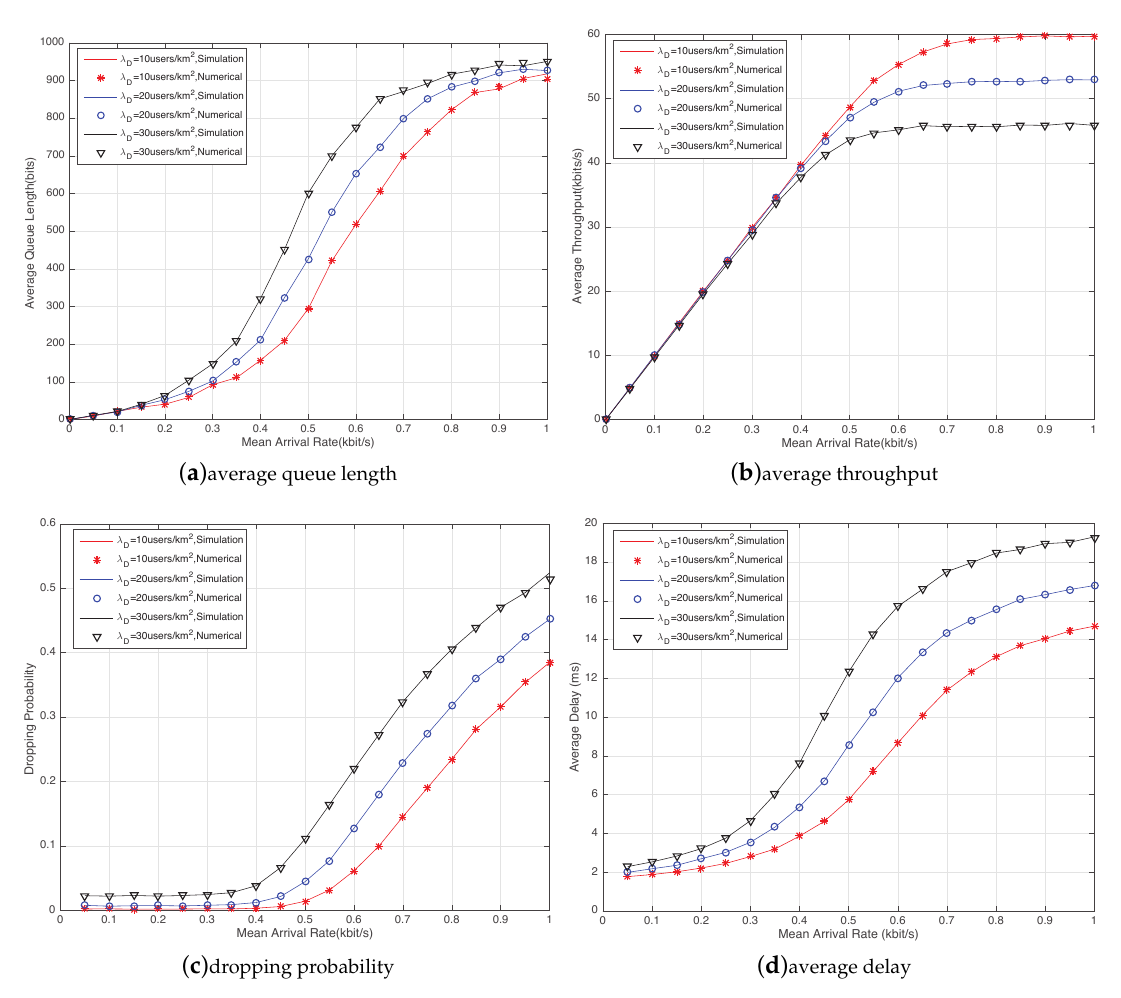
Figure 4. The D2D performance parameters versus packet arrival rate for different D2D densities λ D